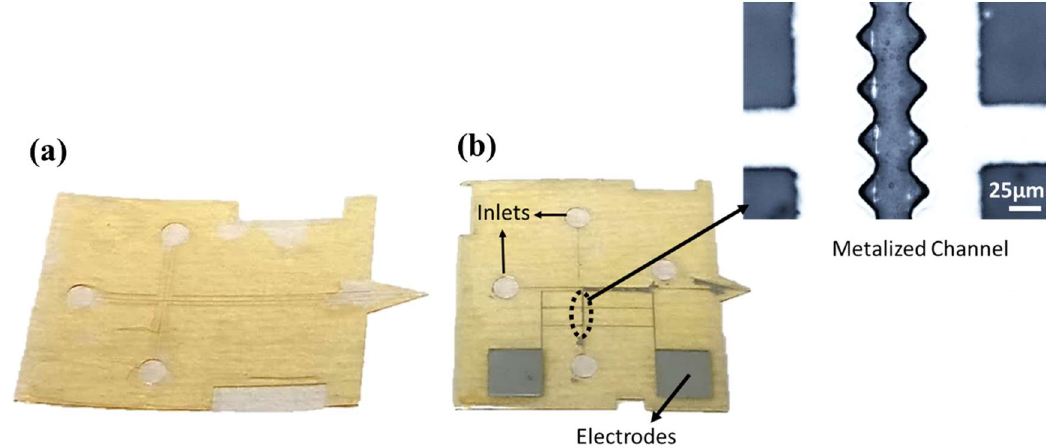
Figure 2. Microfabricated multilayer SU-8 chips ( a ) the multilayered SU-8 electrospray ionization (ESI) chip for mass spectrometer analysis ( b ) metalized SU-8 chip with electrodes. The insert shows the channels which are metalized by lift-off.